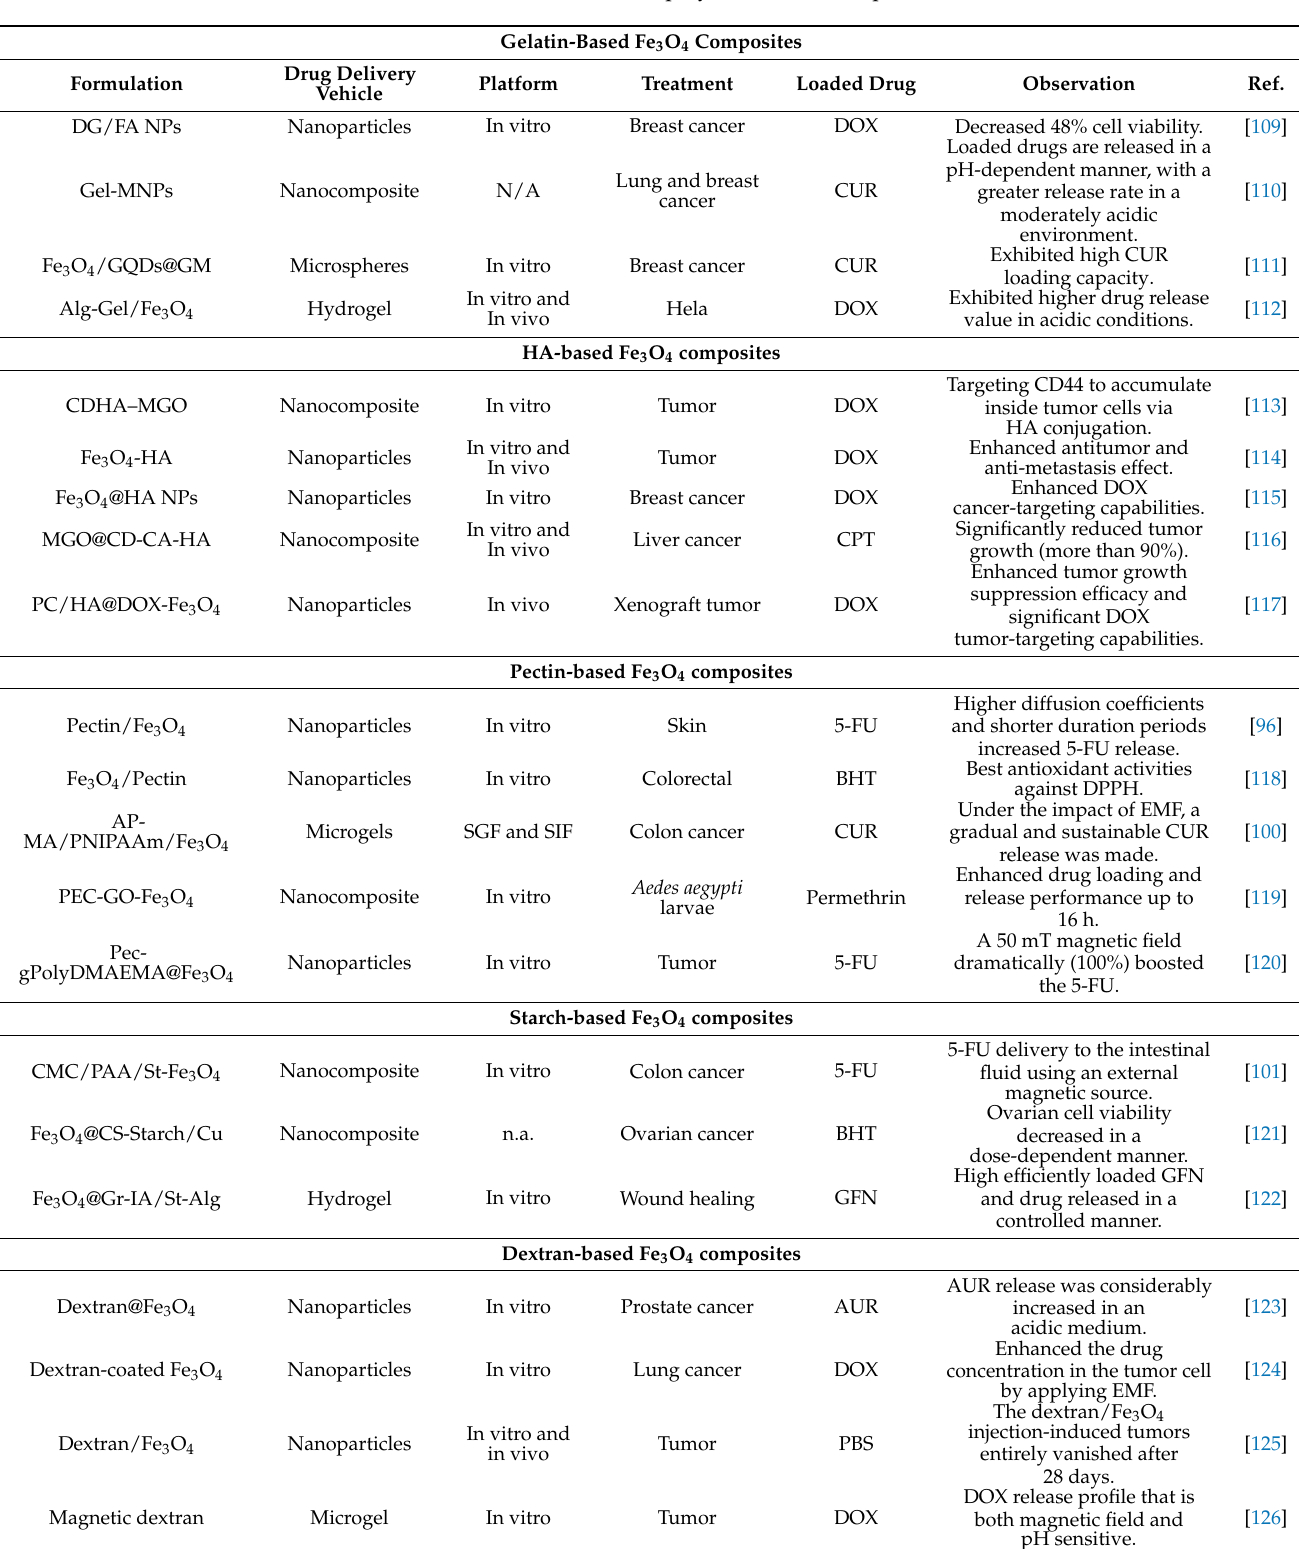
Table 7. Recent studies on natural polymeric MNP composites in